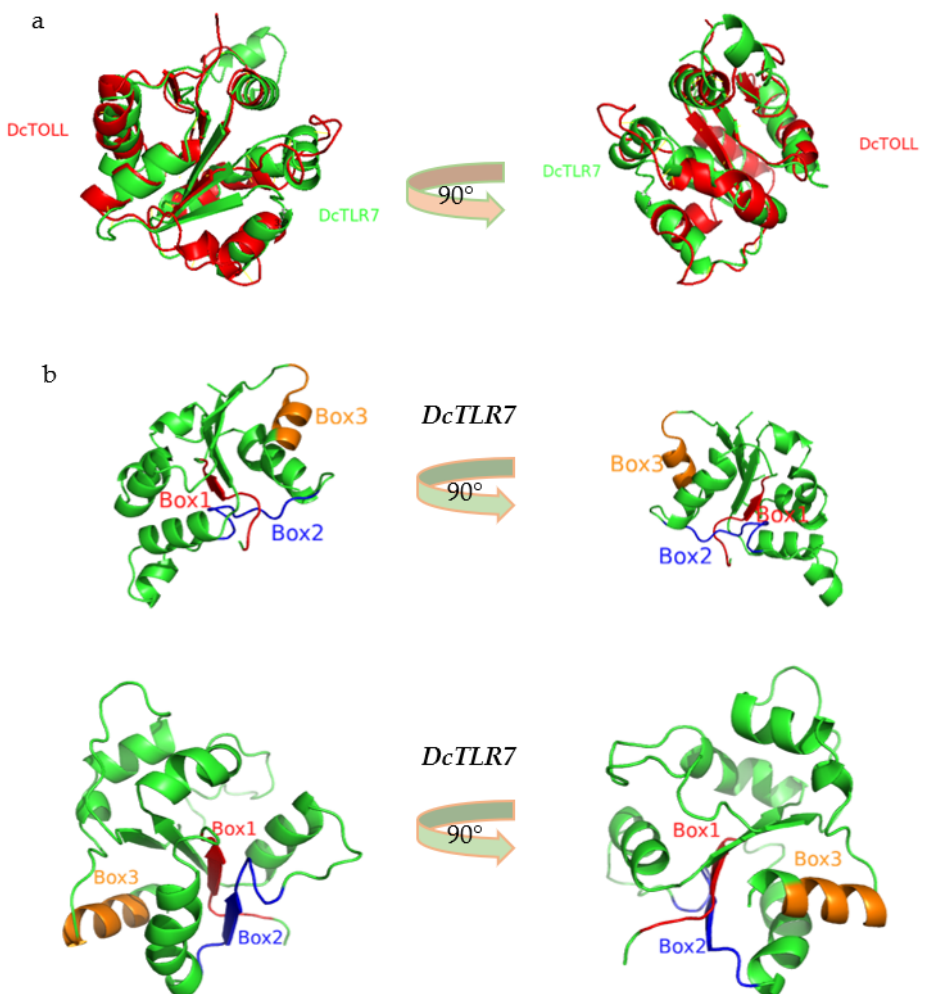
Figure 5. ( a ) Structural alignments of two TIR domains models from Diaphorina citri. ( b ) The 3D model of the TIR domain in DcTLR7 and DcTOLL. Box 1, Box 2 and Box 3 are labeled in different colors.